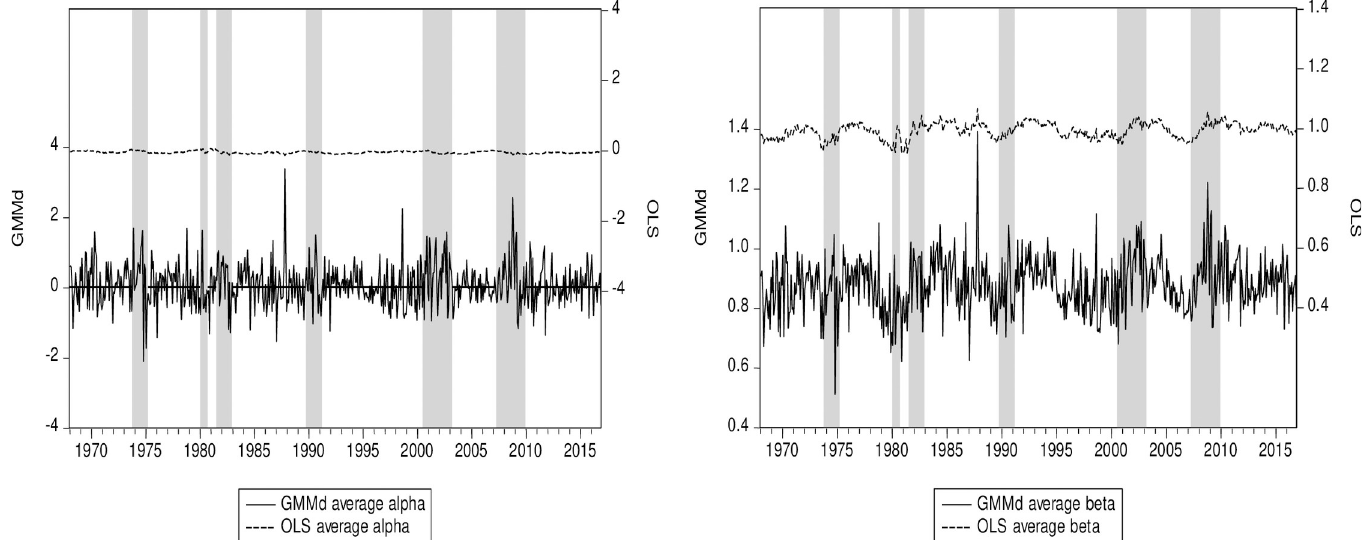
Fig 2. (a) 12-sector average alpha RIV GMM & OLS. (b) 12-sector average beta RIV GMM & OLS. Notes: To capture the business cycle, we use IML as the main driver in the dynamic Eq (9) for our cyclical beta. RIV GMM (GMMd) is our robust instrumental variables approach. Shaded areas represent US recessions or crises. The OLS and GMM series are plotted on the same